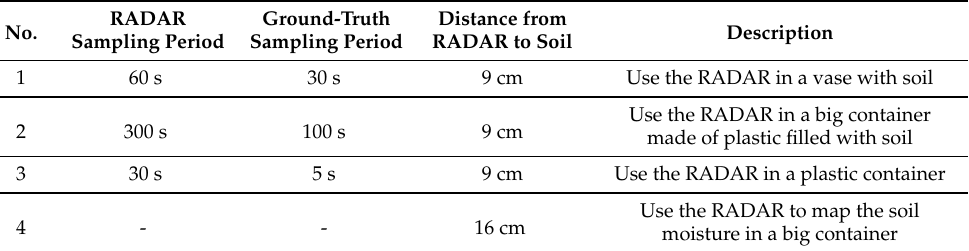
Table 2. Summary of the four experiments implemented.